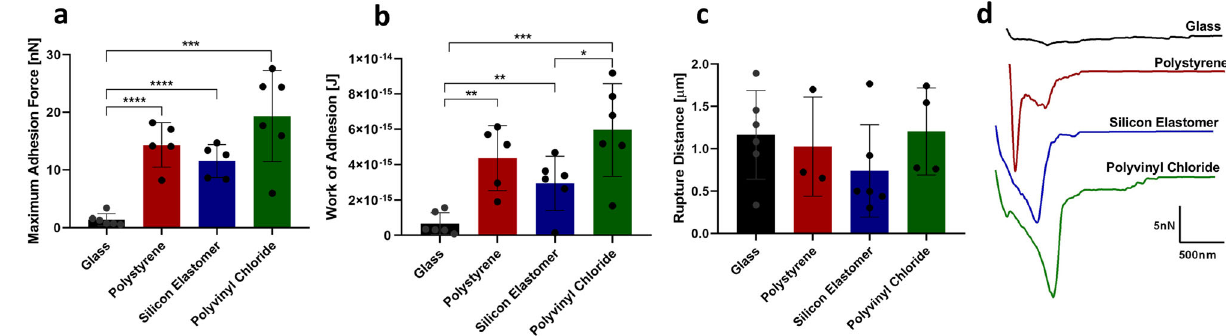
Fig. 1 Interaction of C. glabrata wild-type strain KUE100 with glass, polystyrene, silicone elastomer, and polyvinyl chloride by SCFS. Average of the: a maximal adhesion force, b work of adhesion, and c rupture distance measured on each retraction curve. d Representative force – distance curves of the interaction with glass (black), polystyrene (red), silicone elastomer (blue), and polyvinyl chloride (green). For every condition, at least 5 yeast cells, from at least 3 independent cell cultures, were immobilized on the cantilever for the interaction of each material and 256 force – distance curves were recorded. Error bars indicate SDs. * P < 0.05; ** P < 0.01; *** P < 0.001; **** P < 0.0001, n ≥